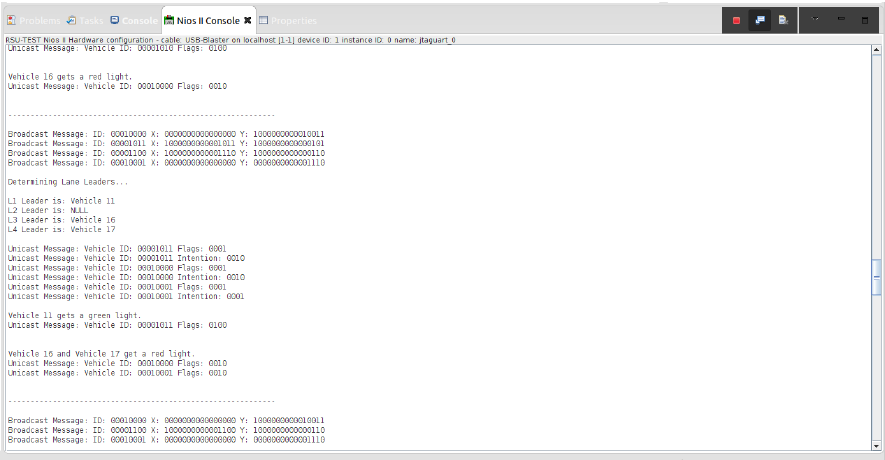
Figure 15. The above screenshot from the Nios II Eclipse Console demonstrates the successful traffic management of four vehicles at the blind